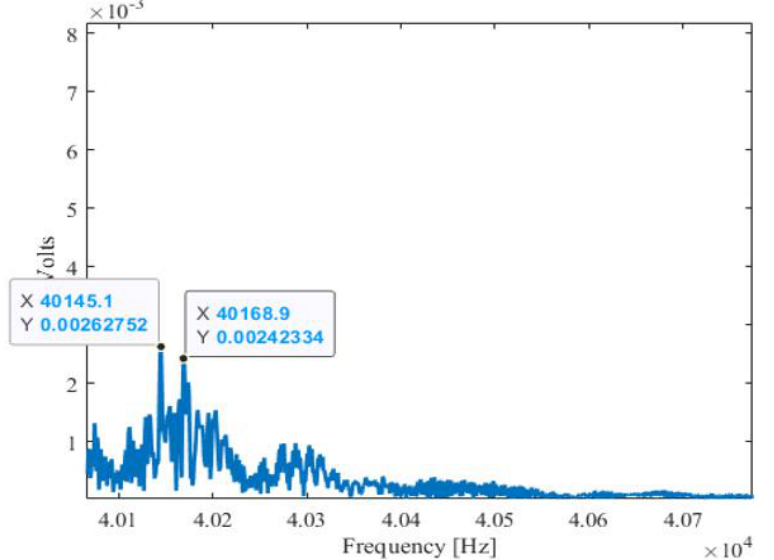
Figure 8. DAQ recording Doppler frequency shift of 2 objects placed at an angle 35 ◦ , and 50 ◦ in time domain respectively.